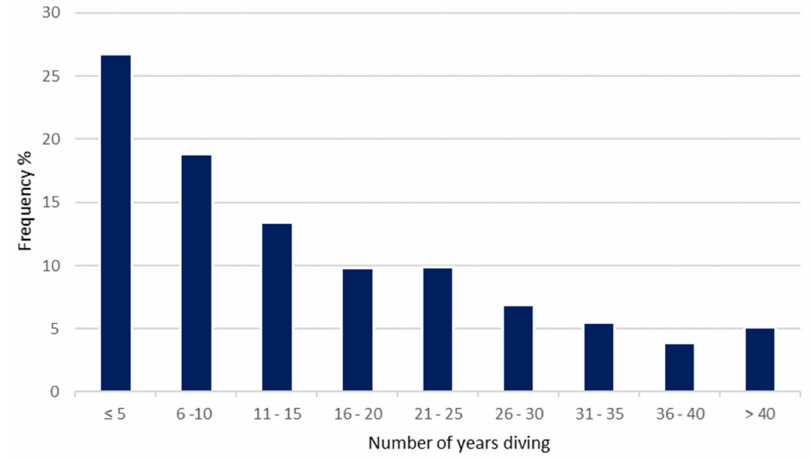
Figure 4. Number of years diving.